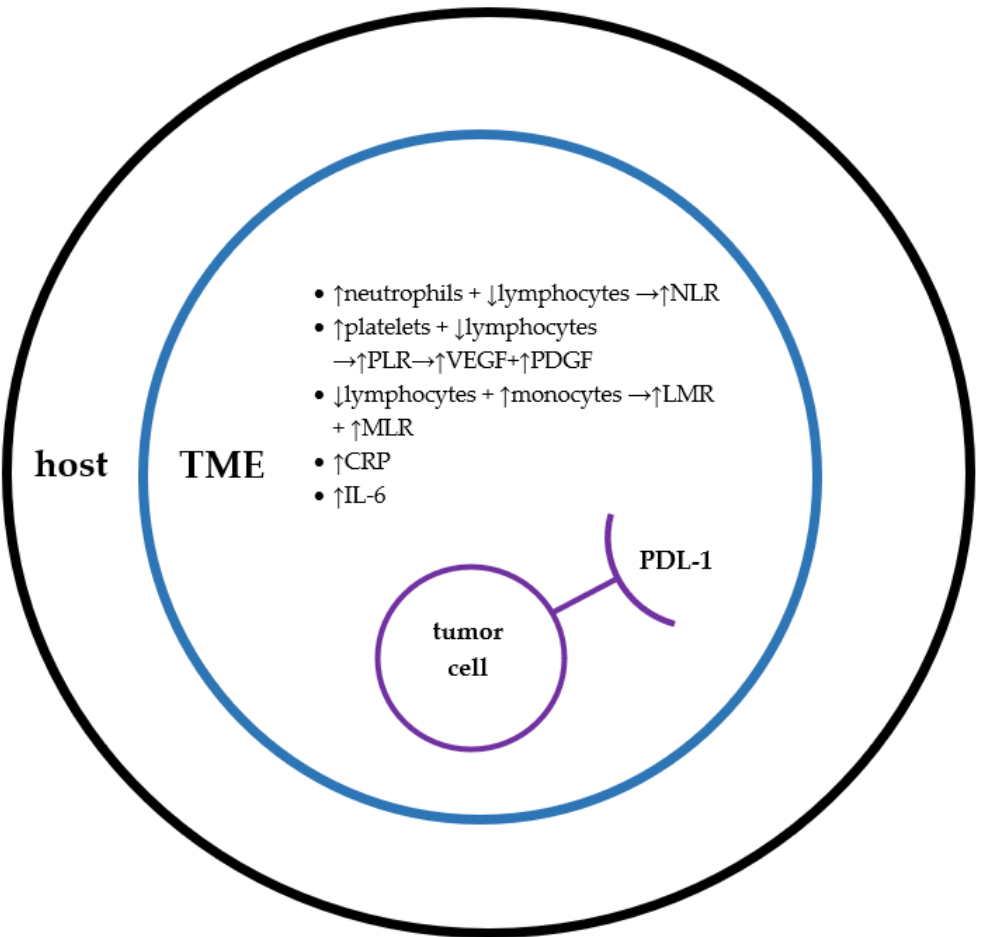
Figure 1. Interaction of various factors in host, tumor microenvironment (TME) that leads to tumor cell proliferation.